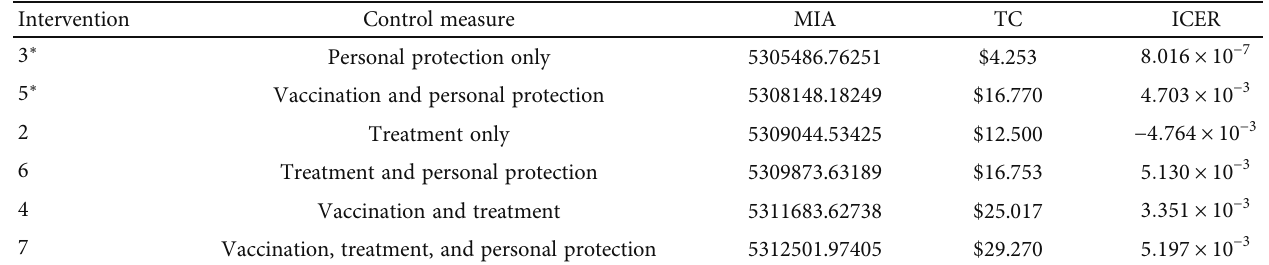
Table 7: Comparing ICER I 3 with I 5 .